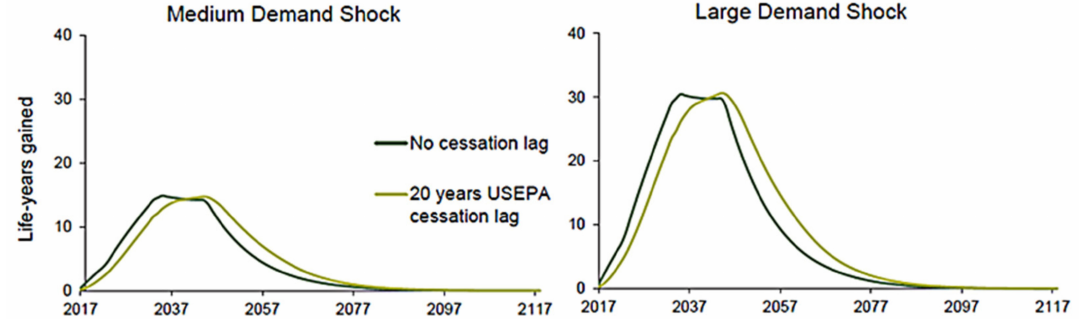
Figure 5. Central estimates of LY gained for the extended GMR population over the 2017–2118 period for medium and large demand shock scenarios, without lag and with the USEPA distributed lag.